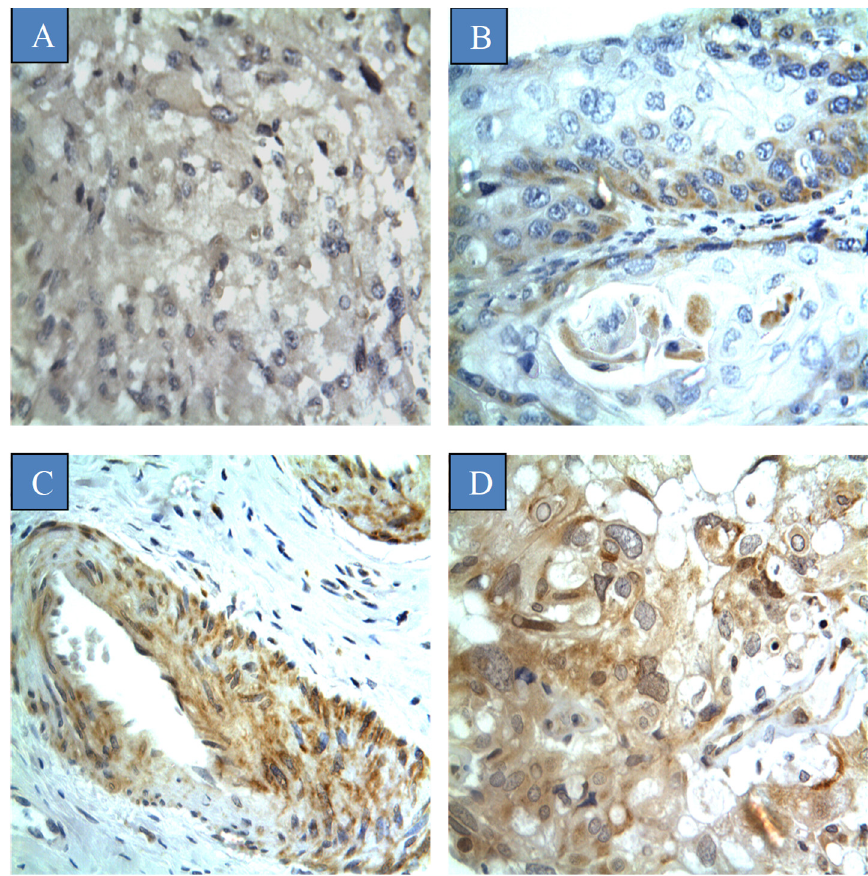
Figure 1. Different scores of CYP4Z1 expression in cervical cancer tissues: ( A ) score ‘negative’ showing no expression in the tissue at all; ( B ) score ‘low’ showing expression less than 33% of cells; ( C ) score ‘moderate’ showing expression in 34–66% of the cells, and; ( D ) score ‘strong’ showing expression in more than 67% of the cells. Magnification (×400).